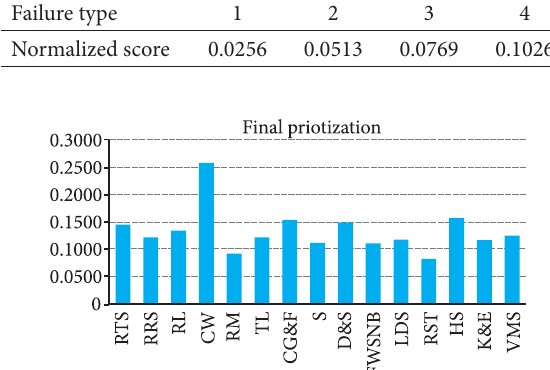
Fig. 3. Final prioritization weights for trunk road network sub- assets and attending